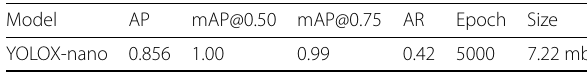
Table 1 Results obtained for YOLOX-nano model trained to detect